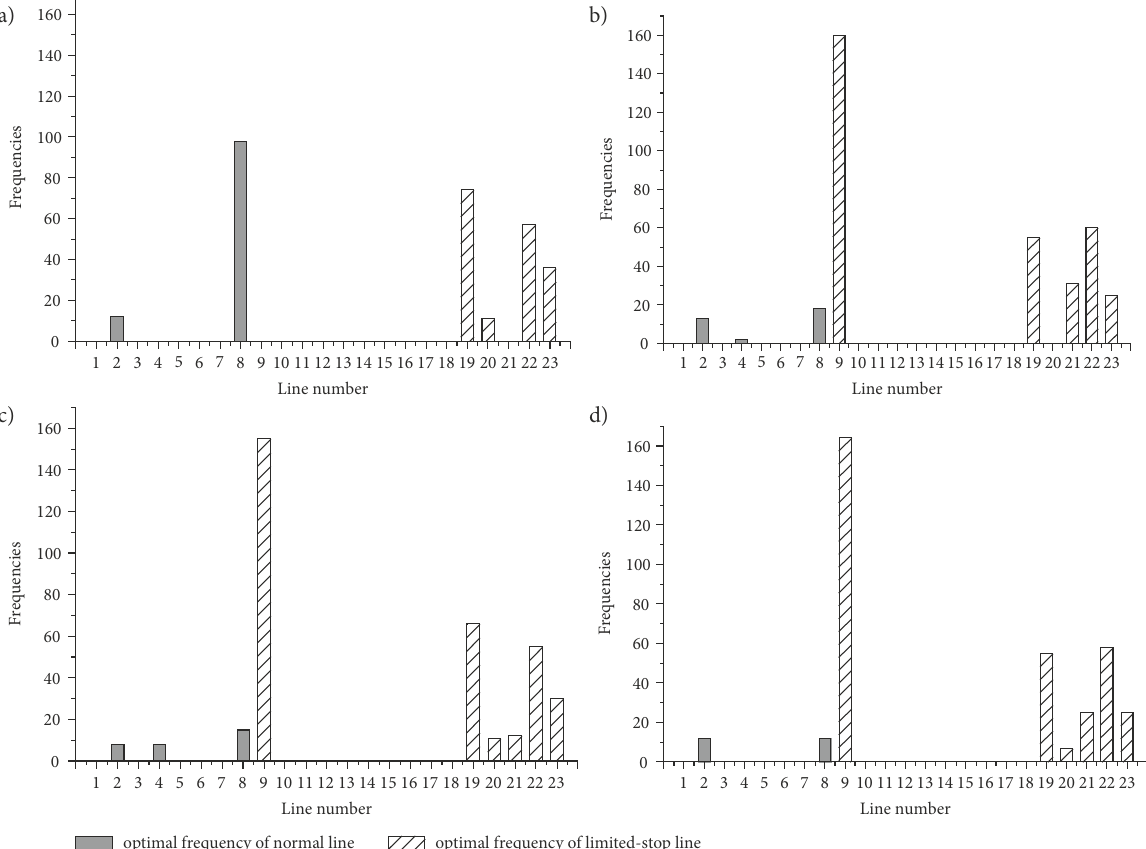
Figure 4. Optimal line frequencies with no transfer discounts under different times of day: a – 0.5 multiplier of a basic bus fare;